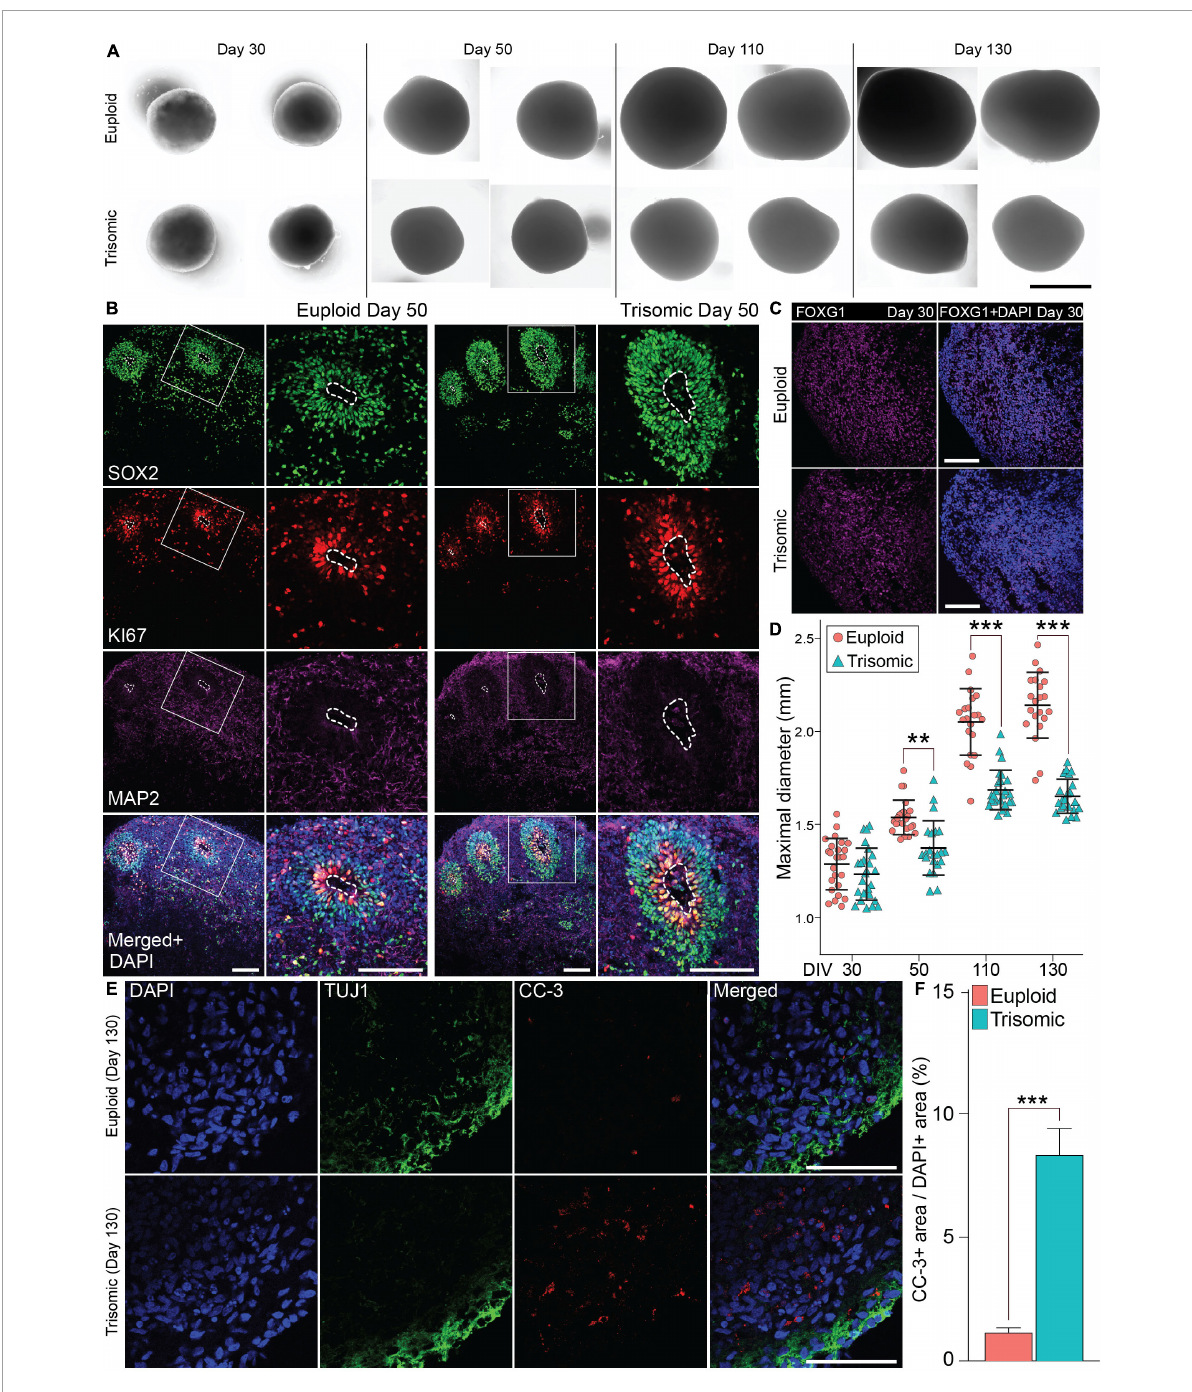
FIGURE2 Generation and characterization of isogenic cortical spheroids (CS). (A) Bright field images of euploid and trisomic CS on day 30, 50, 110, and 130. Scale bar, 1 mm. (B) Immunohistochemistry (IHC) staining of SOX2 showing the presence of the rosette-like structures enriched with ki67 marker in euploid and trisomic CS on day 50. Scale bar, 100 µ m (C) IHC staining with FOXG1 antibody on day 30 in euploid and trisomic CS. (D) Jitter plot showing the distribution of CS diameters on days 30 (euploid, n = 25; trisomic, n = 25), 50 (euploid, n = 23; trisomic, n = 22), 110 (euploid, n = 21; trisomic, n = 25), and 130 (euploid, n = 21; trisomic, n = 22). Euploid samples are represented by red circles, while trisomic samples are represented by blue triangles. The results are analyzed by one way ANOVA followed by Tukey’s multiple comparisons test. (E) IHC staining of CC-3 and TUJ1 in euploid and trisomic CS on day 130. Scale bar, 50 µ m. (F) Bar graph showing the percentage of area with CC-3 IHC signal over the area with DAPI signal quantified through particles analysis via ImageJ s and analyzed using student t -test (euploid, n = 14; trisomic, n = 13). Error bar represents standard error. ** p < 0.01; *** p < 0.001. The quantification results are generated from three independent differentiation